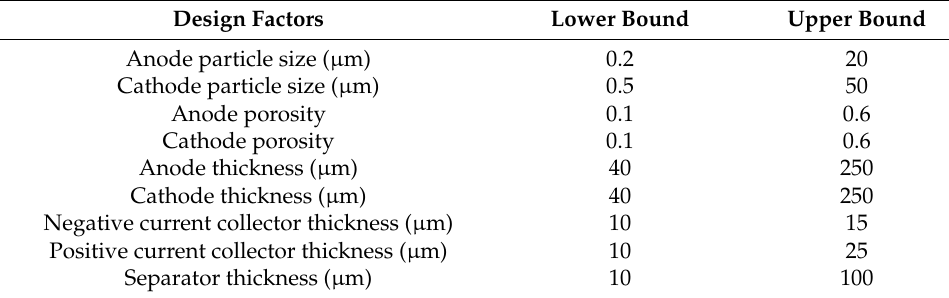
Table 3. Design factors and their bounds